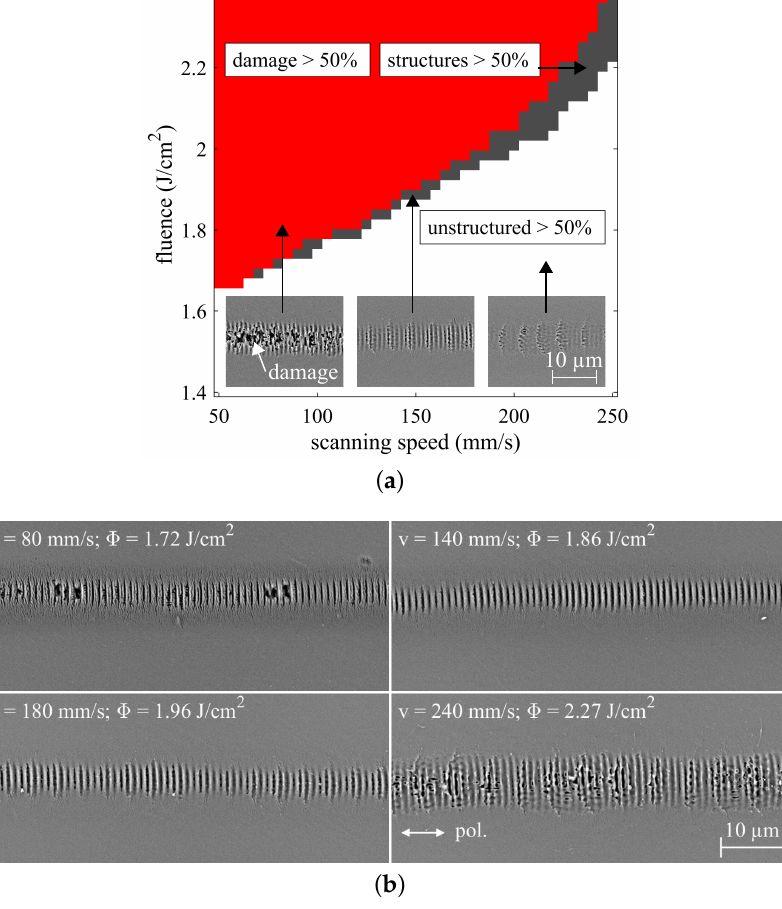
Figure 2. ( a ) A 41 × 41 matrix including scanning speed variations between 50 mm/s and 250 mm/s and fluence variations between 1.40 J/cm 2 and 2.37 J/cm 2 ; scanning direction is set parallel to the laser polarization. Different regimes determine whether the line includes more than 50% damaged, structured and unstructured areas. ( b ) SEM images of 1D-LSFL on fused silica including more than 50% structures (Region II) for different scanning speeds and